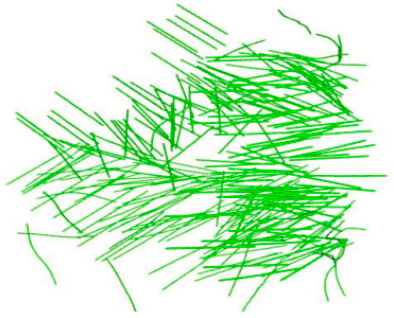
Figure 13. Discrete element model of feeding device. ( a ) Three-dimensional simplified model; ( b ) Discrete element model. Table 2. Mechanical parameters and mutual contact factors of materials.